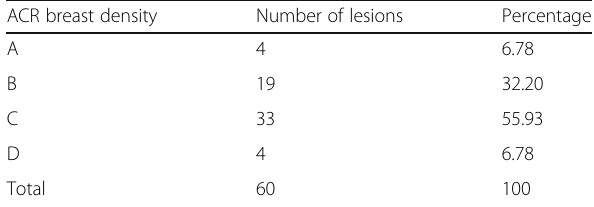
Table 3 Distribution of cases according to the ACR BIRADS lexicon breast density